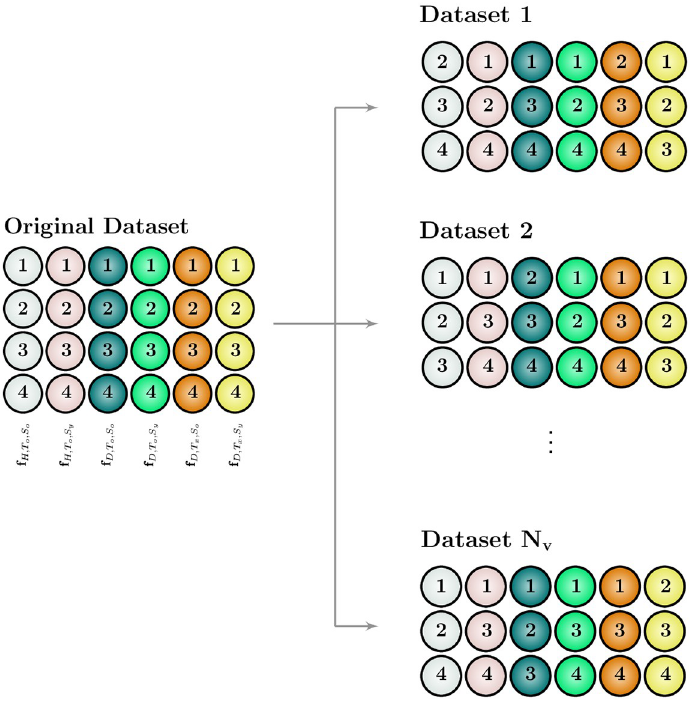
Fig 3. Miniaturization of the resampling based leave-one-out validation approach per plate. Left: original collected protein release d -dimensional vectors f for the six different cell states supported by COMBSecretomics ( H ; T ; S ; H ; T ; S ; D ; T ; S ; D ; T ; S ; D ; T ; S ; D ; T ; S ). For each cell state, four intra-plate replicate o o o y o o o y x o x y measurements are shown as rows along with the corresponding replicate number. D cells are either untreated ( T o ) or ) while H cells are untreated ( T ). Both D and H cells are either stimulated ( S treated ( T x o wells of different cell states are colored differently. Right: N v user-defined validation datasets are automatically created by employing a leave-one-out procedure among the four intra-plate replicate measurements for each cell state.